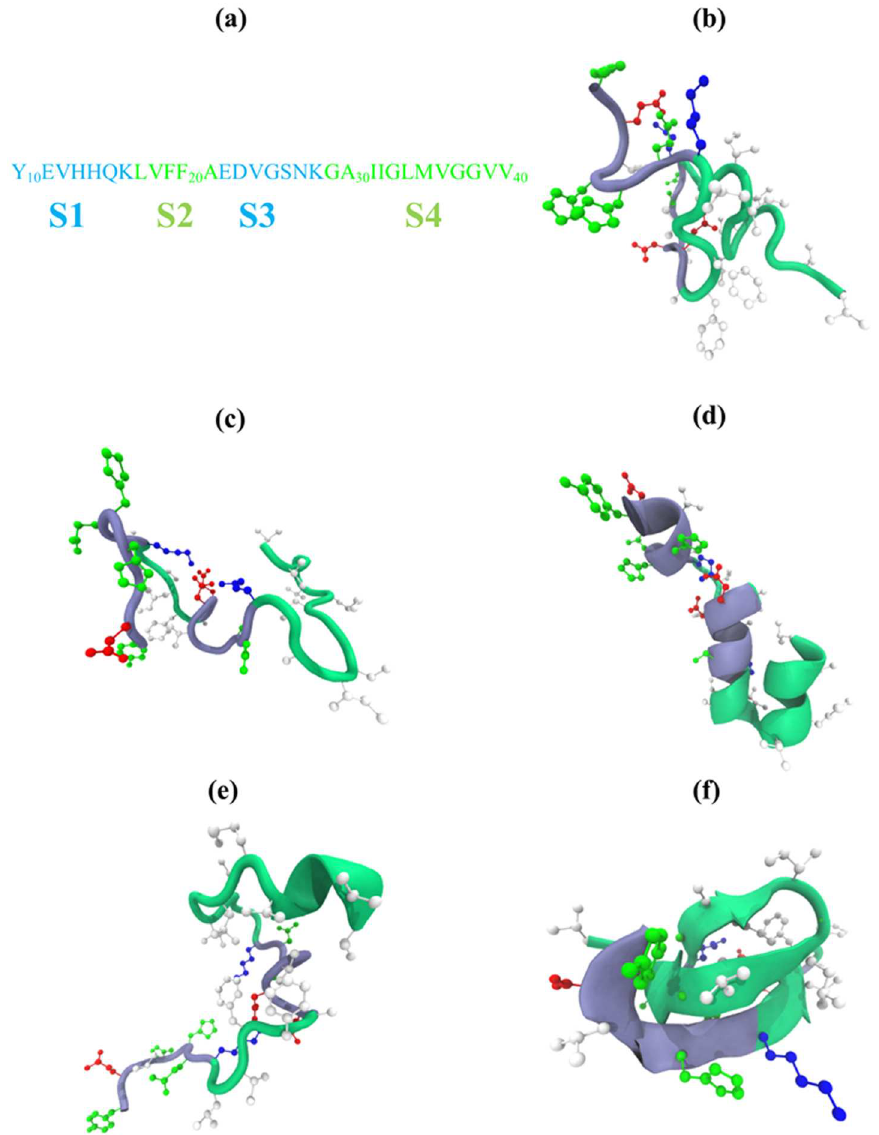
hydrophilic turn (S3, residues 22-28), and hydrophobic C-terminal (S4, residues 29-40). (b-f) Representative conformations of A β 10-40peptidein five force fields: (b) C36, (c) C36s, (d) C22 * ,(e) C22cmap, and (f) OPLS-AA. C36, C36s, and C22cmapstructures in (b), (c), (e) show disorderedpeptide,whereas C22 * in (d) and OPLS-AA in (f) structures illustrate helix or β propensities characterizing the respective force field. Side chains are colored to representhydrophobic(in light grey), polar (in green), positivelycharged(in blue), and negatively charged(in red) residues.The backbonecoloringfollows the scheme used in (a).